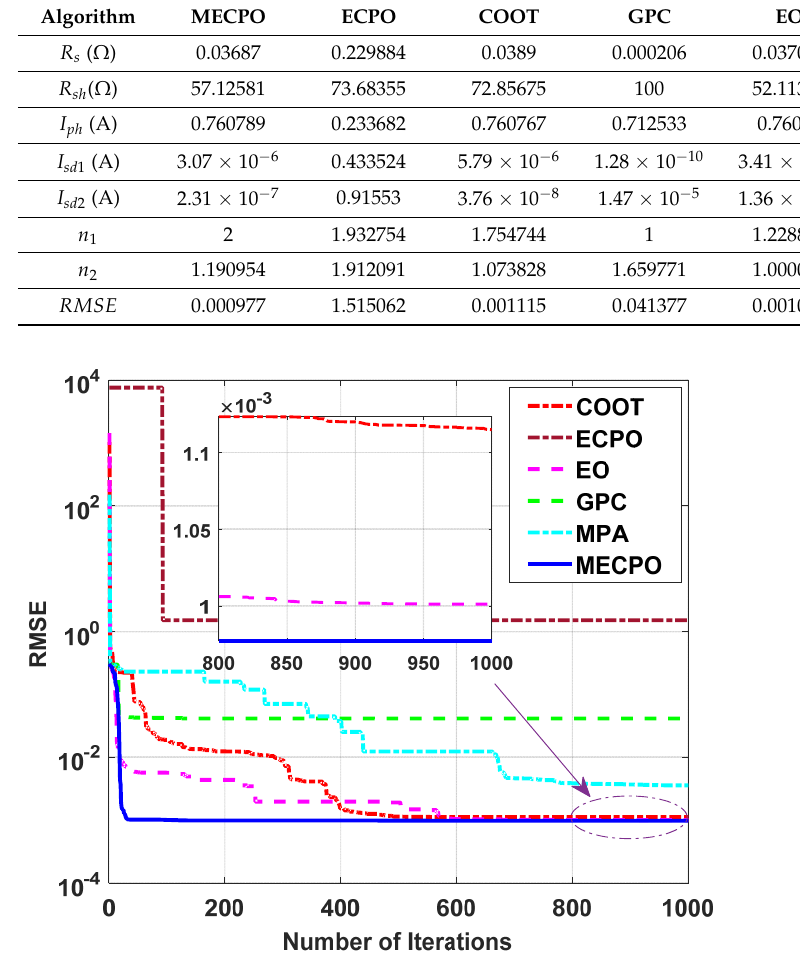
Figure 12. Convergence curve of the MECPO and other recent algorithms for the DDM.